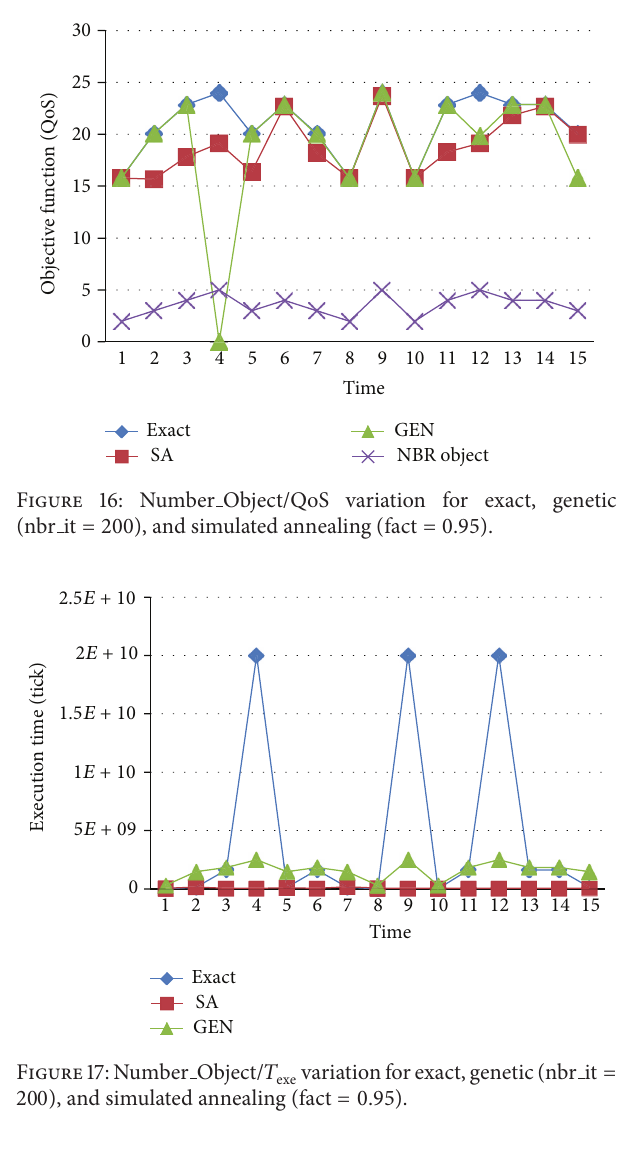
variation for exact and selected exe